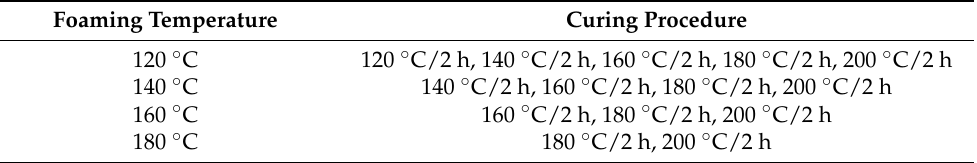
Figure 1. Schematic diagram for preparation process of BZPN foam. Table 1. Curing procedure of BZPN foams.